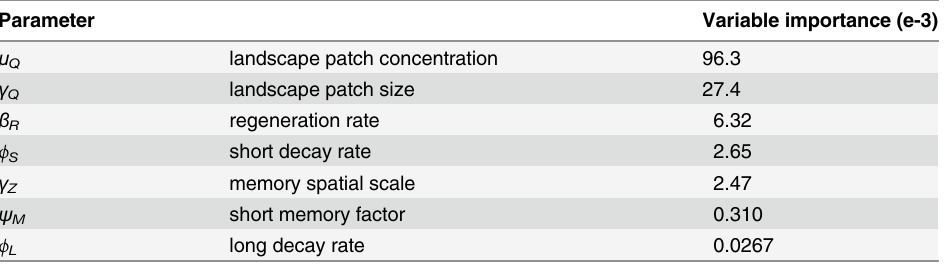
Table 5. Permutation importance scores (mean decrease in accuracy) calculated using random for- ests for the memory model. Results shown treat parameters as continuous variables. Results were similar when parameters were treated as